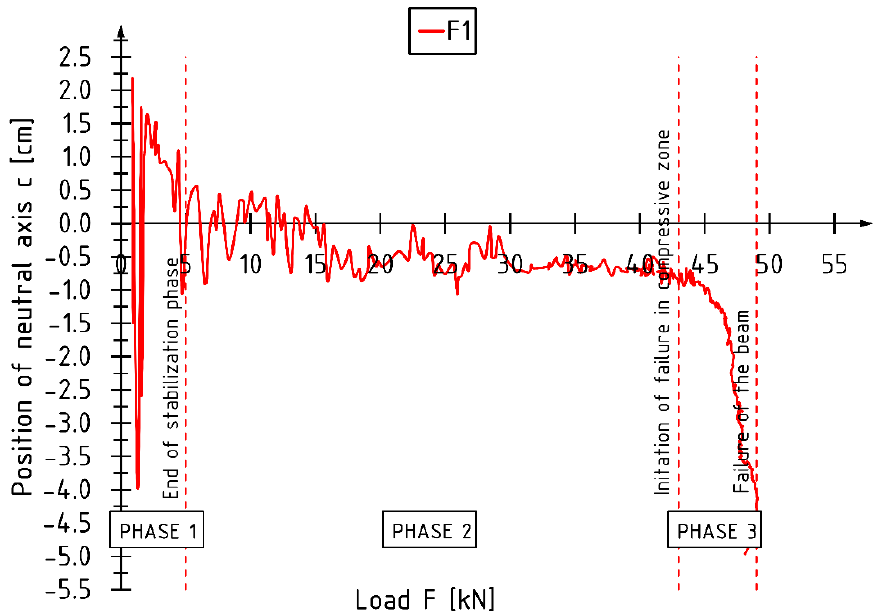
13 of 17 Figure 10. Changes in position of neutral axis for beam: ( a ) A1; ( b ) B1; ( c ) C1; ( d ) D1; ( e ) E1; ( f ) F1. The course of changes in curvature can be divided into phases similar to those for changes in stiffness described in Section 3.2 (Figure 11). As the load increases, the amplitude of displacements of the neutral axis position decreases — the highest values are recorded in the initial phase of the test. During this time, the neutral axis can repeatedly change its position relative to the center of the height of the cross-section, passing between positive and negative values of the coordinates of the ordinate axis. This phenomenon is typical for all tested elements (phase 1). The middle phase, the largest one, is when no significant changes occur (phase 2). The final value of the position of the center of gravity